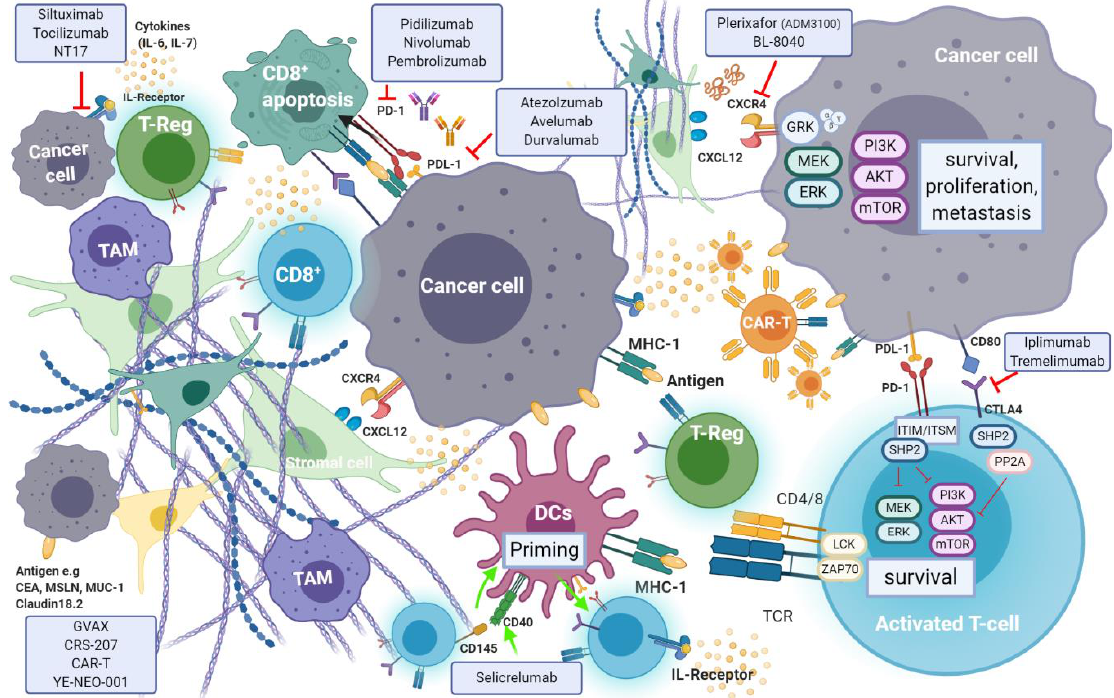
Figure 7. Cancer cell mediated activation of immunosuppressive cells is promoted through secretion and expression of immunosuppressive cytokines and membrane bound ligands (e.g., PDL-1, CTLA-4), that further hinder anti-tumour response. Regulation of T-cell response occurs through T-cell receptor (TCRs) interaction with their respective ligands, following which signalling cascade action antagonizes T-cell activation. The induction of endogenous cancer cell survival, proliferation and metastasis by pancreatic stellate cells (PSCs) is enabled through the CXCR4-CXCL12 axis. Such processes are targeted in immunotherapy with the aim of triggering anti-tumour immunity or direct targeting of cancer cells.